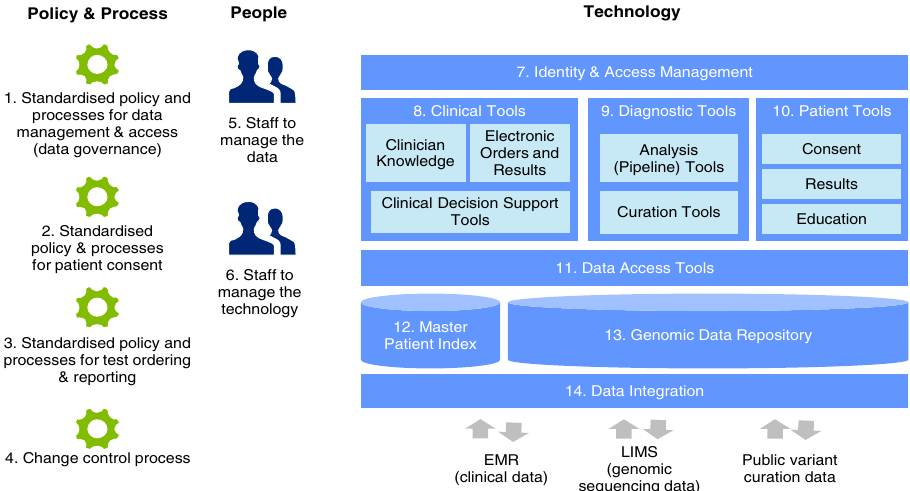
Fig. 3 Conceptual diagram of the Melbourne Genomics Health Alliance shared information management platform for future implementation. The core of the common genomic data management platform is the Genomic Data Repository — a central place to store genomic sequence data. The Clinical Tools, Diagnostic Tools and Patient Tools are shared by the Alliance members and integrate with their own systems including EMR and LIMS. Further detail is in Supplementary Material 1